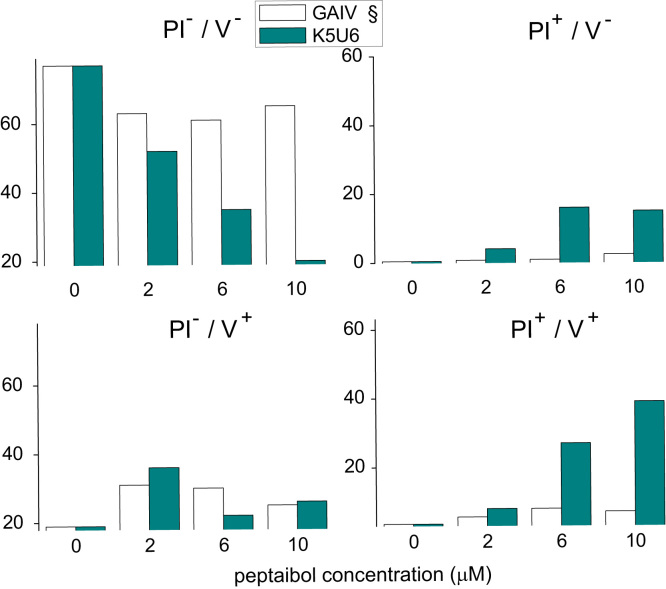
Induction of necrosis (PI+/V−), apoptosis (PI−/V+) or late apoptosis (PI+/V+) in HeLa cells treated with K5U6 analog of trichogin. Cells treated as described in Fig. 3 were stained with Annexin-V-FITC and Propidium iodide, and subjected to FACS analysis. Bars are the percentage of viable (PI−/V−), necrotic (PI+/V−), apoptotic (PI−/V+) and late apoptotic (PI+/V+) cells from a representative experiment out of three. § Indicates data from [6] for comparison.